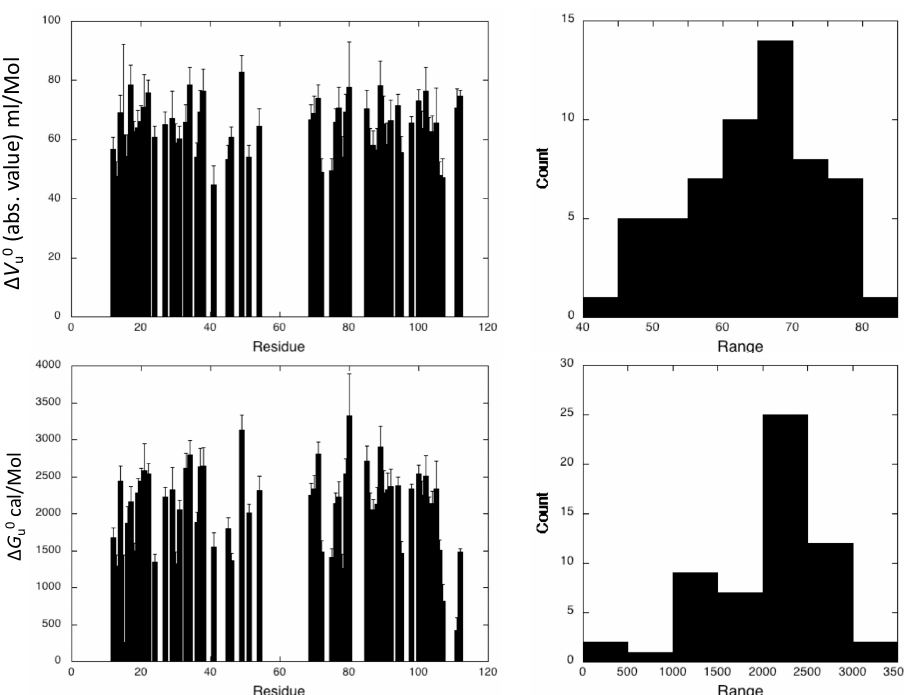
Figure 5. Steady-state thermodynamic parameters. (Right) Apparent residue-specific ∆ V u 0 (absolute values) (top) and ∆ G u 0 (bottom) values obtained through the fit of the intensity decrease of the 2D { 1 H- 15 N} HSQC cross-peaks with pressure recorded on DEN4-ED3, plotted versus the protein sequence. (Left) Distribution of the values of ∆ V u 0 (top) and ∆ G u 0 .